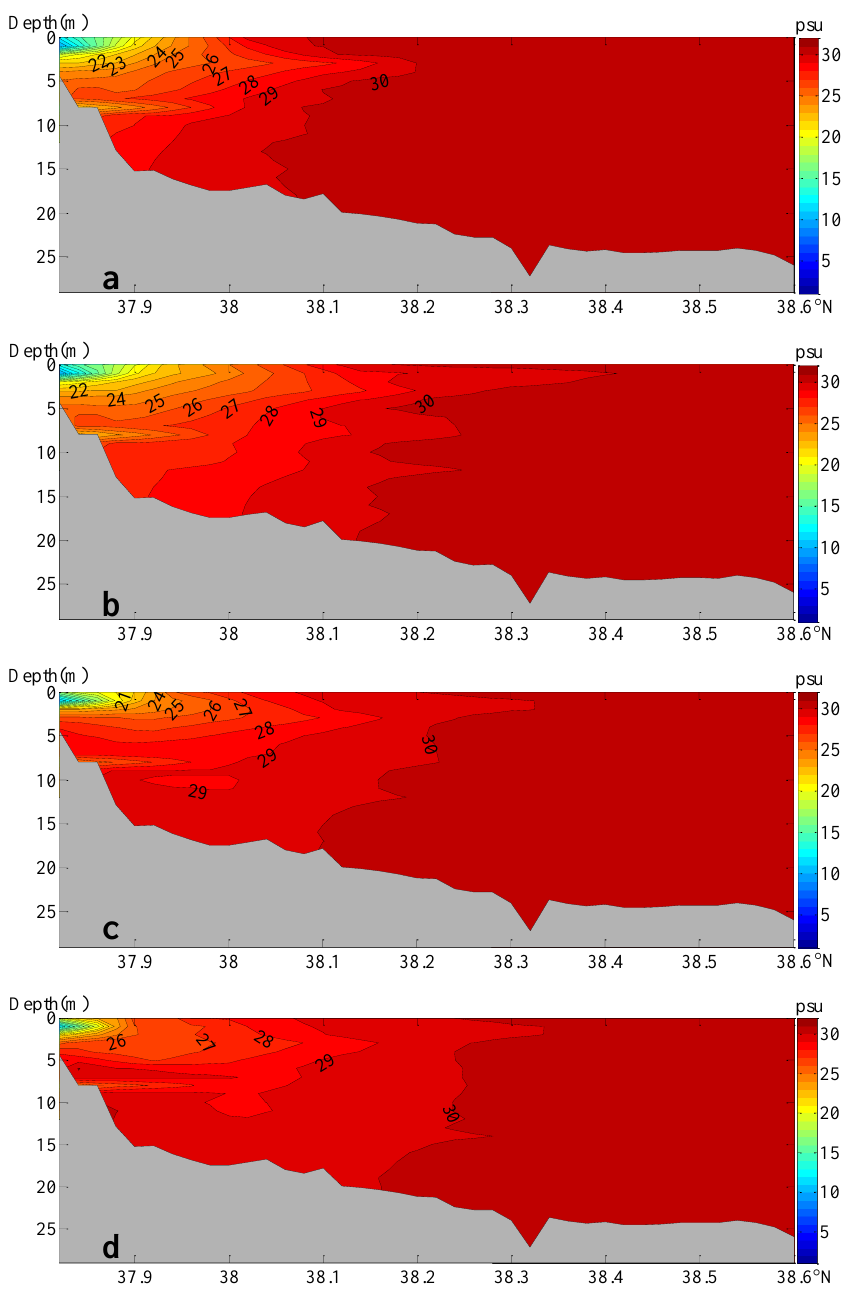
Figure 14. Vertical salinity distribution at different wind speeds in the wet season (( a ): case 3, ( b ): case 4, ( c ): case 5, ( d ): case 6).